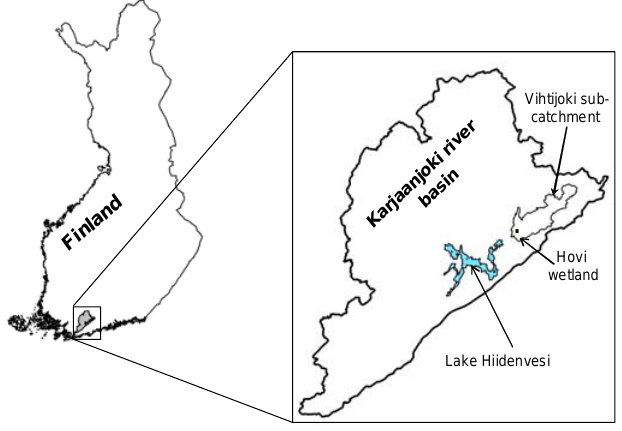
Figure 1. Location of the Karjaanjoki river basin in Finland and the intensive measuring areas of Lake Hiidenvesi, the Hovi farm and the Vihtijoki sub-catchment.